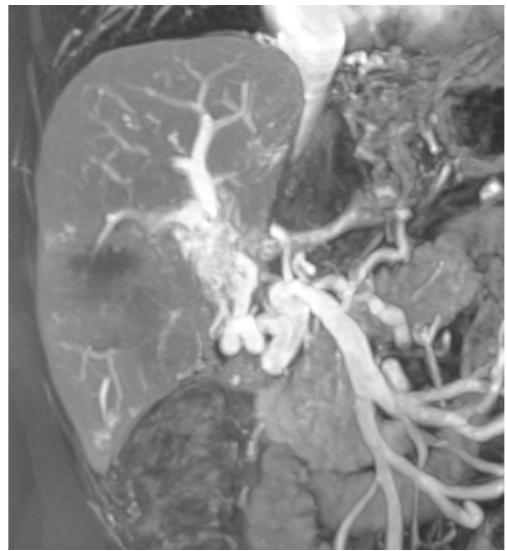
Figure 1: MR angiography showed PVAS with main portal vein occluded completely.